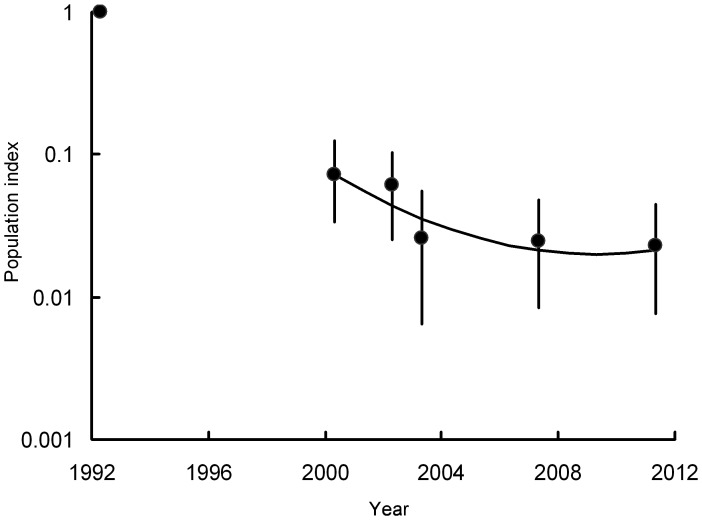
Population indices and trend of Gyps indicus and G. tenuirostris combined.Circles show indices of population density, relative to that in 1992, estimated by log-linear Poisson regression preformed on data from six road transect surveys in India. Vertical lines show 95% bootstrap confidence limits. The curve shows the quadratic log-linear population trend fitted to data for the period 2000–2011.